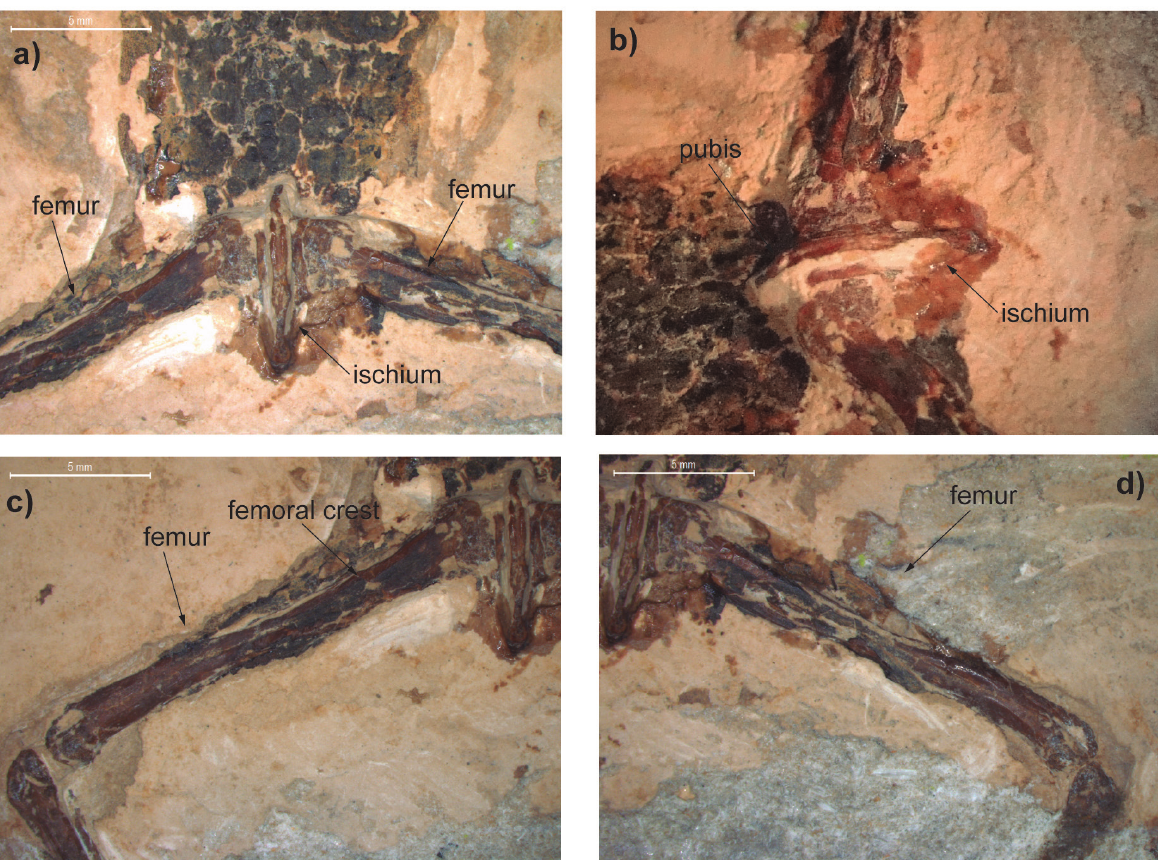
Figure 4. Primaevorana cratensis, holotype (GP/2E-9497) from Crato Formation, Lower Cretaceous (Aptian), region of Nova Olinda, Araripe Basin, Ceará state, Northeastern Brazil. a) Pelvic girdle; b) Detail view of pelvic girdle; c) Right hindlimb; d) Left hindlimb. Photographs by Ivan